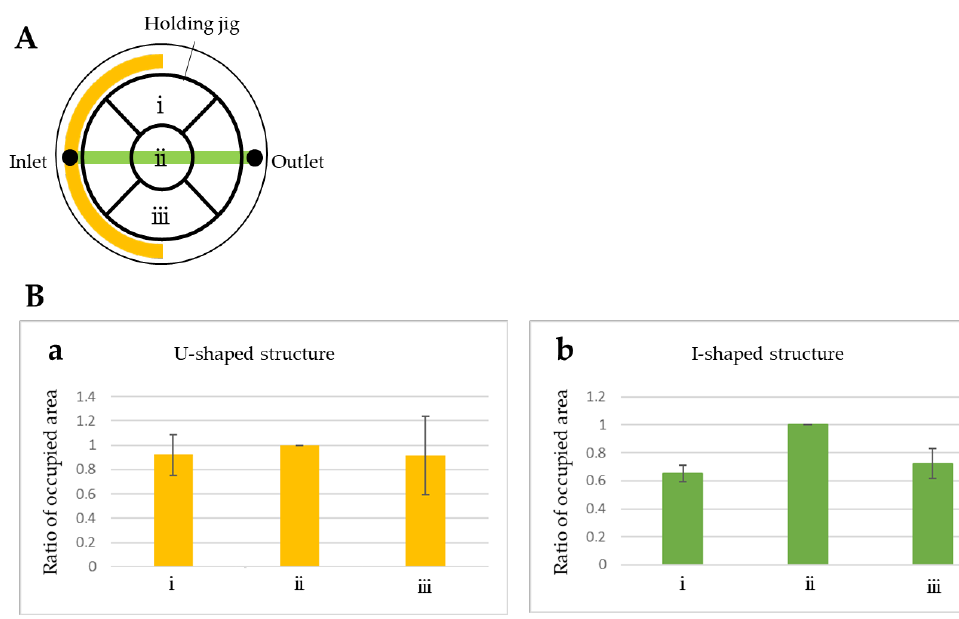
Figure 6. Culture of 293T cells using the CD-adapter. ( A ) Cells were observed at points i, ii, and iii on the vertical line intersecting the center of the straight line that connects the inlet and the outlet. DMEM culture medium supplemented with 10% fetal bovine serum was perfused at a flow rate of 17 µL/min through the inlet for 40 min, and the cells were then cultured for 1 day. ( B ) Cultured cells were imaged at all points, and the area occupied by cells was quantified using ImageJ software. The area occupied at ii was set as 1, and then the relative areas at i and iii were obtained. With the adapter with the I-shaped structure ( b ), the rate of cell proliferation under the small recess structure was significantly higher than that in other places, and no difference in proliferation rates was observed with the adapter with the U-shaped structure ( a ) at points i–iii, and it was possible to culture cells uniformly.